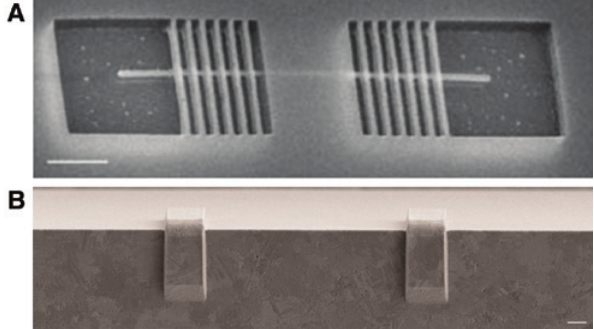
Figure 7: Plasmon resonators made (A) on a silver colloidal nanow- ire by defining DBR mirrors on the surrounding PMMA medium [61] and (B) by adding block reflectors confining a plasmon mode propagating along the wedge [64]. The scale bars in (A) and (B) both correspond to 1 μ